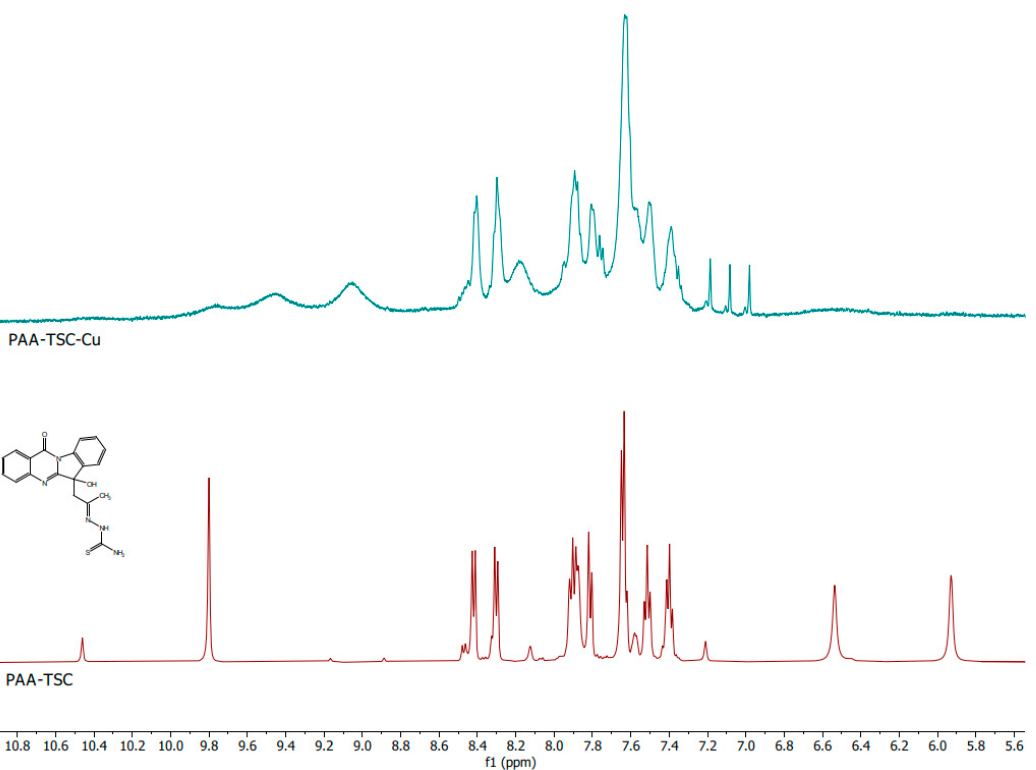
Figure 6. 1 H NMR spectra of the PAA-TSC (below; maroon colour) receptor and comparison with the corresponding complex with Cu(II) ions (above; teal colour).